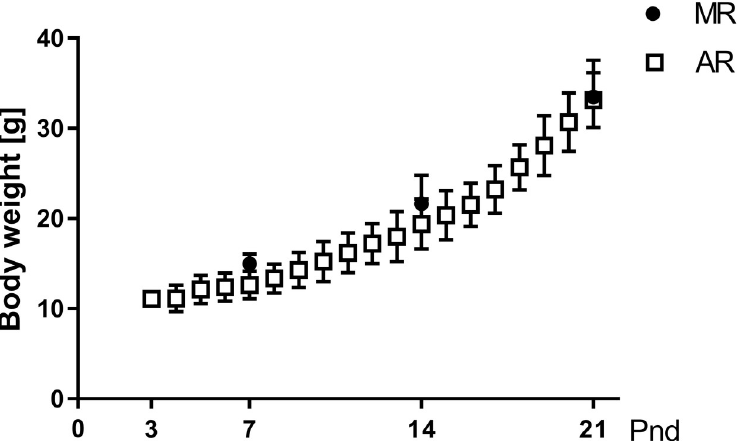
Fig 1. Body weight in MR and AR pups along the lactation period. MR pups (filled circles) were weight at pnd7, pnd14 and pnd21, while AR pups (open squares) were weight daily from pnd3 to pnd21. There were 53 MR pups for each age, and 202 AR pups during the lactation